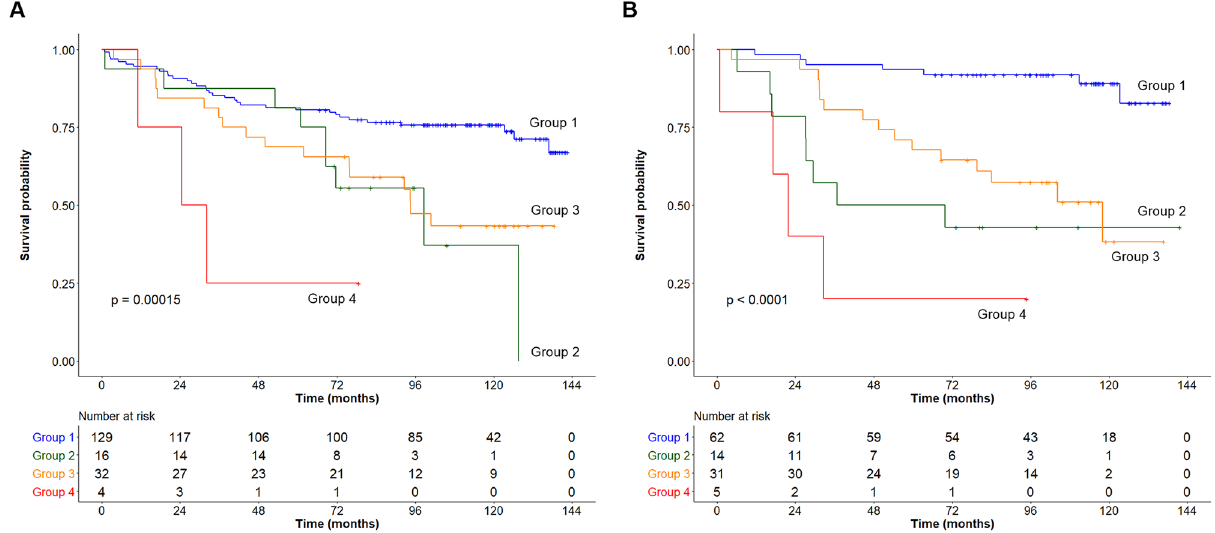
Figure 4. Overall survival estimation in the combination of rVAT and VAT-SUV in males ( A ) and females ( B ). Group 1: low rVAT and low VAT-SUV; Group 2: low rVAT and high VAT-SUV; Group 3: high rVAT and low VAT-SUV; Group 4: high rVAT and high VAT-SUV.